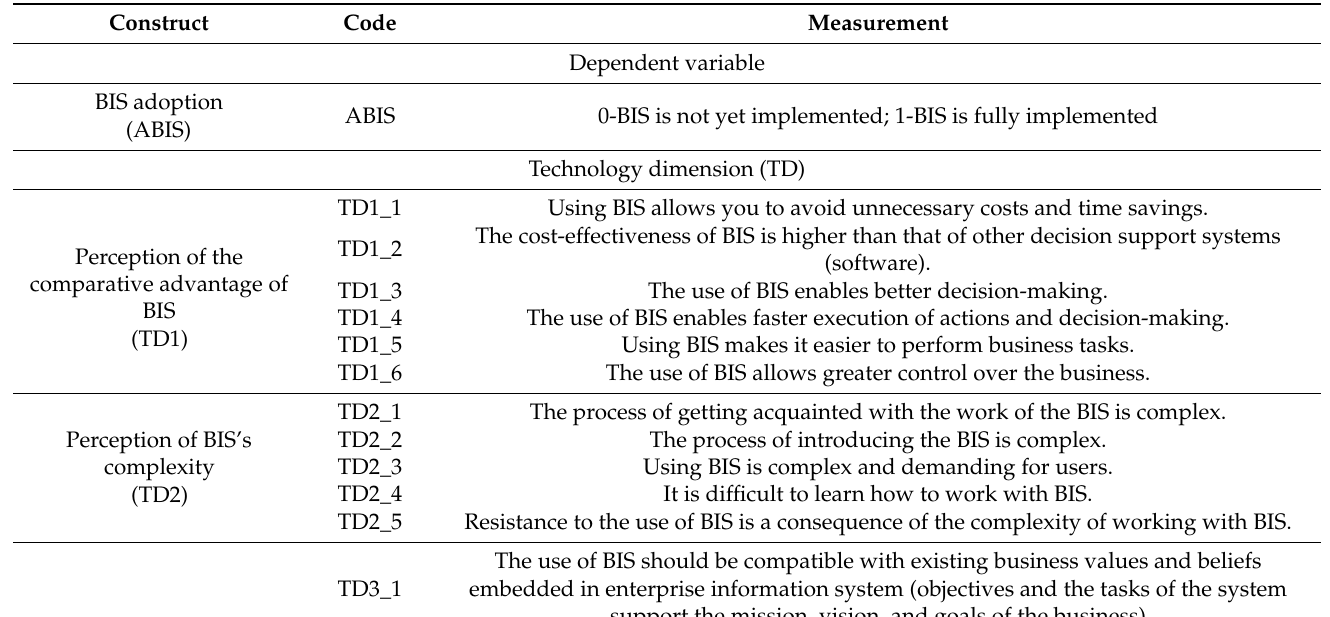
Table 1. Research instrument